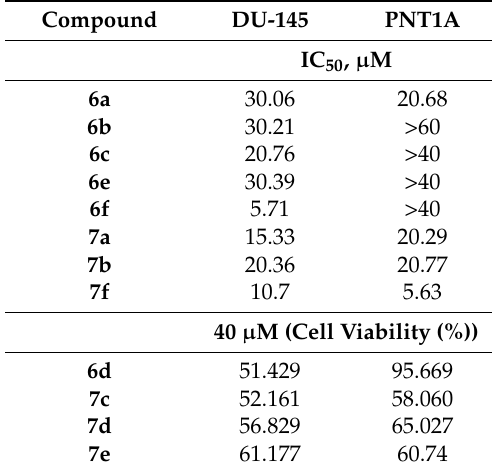
Table 3. Cytotoxic activity evaluated in vitro